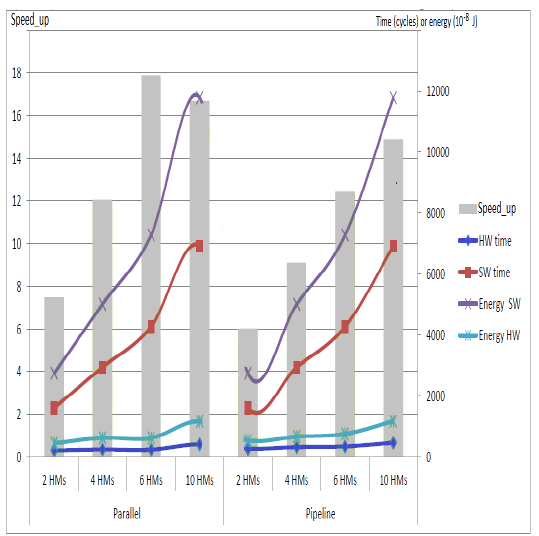
Figure 23. Comparison of the HW and SW implementations of the scalable BN monitors in terms of latency and energy